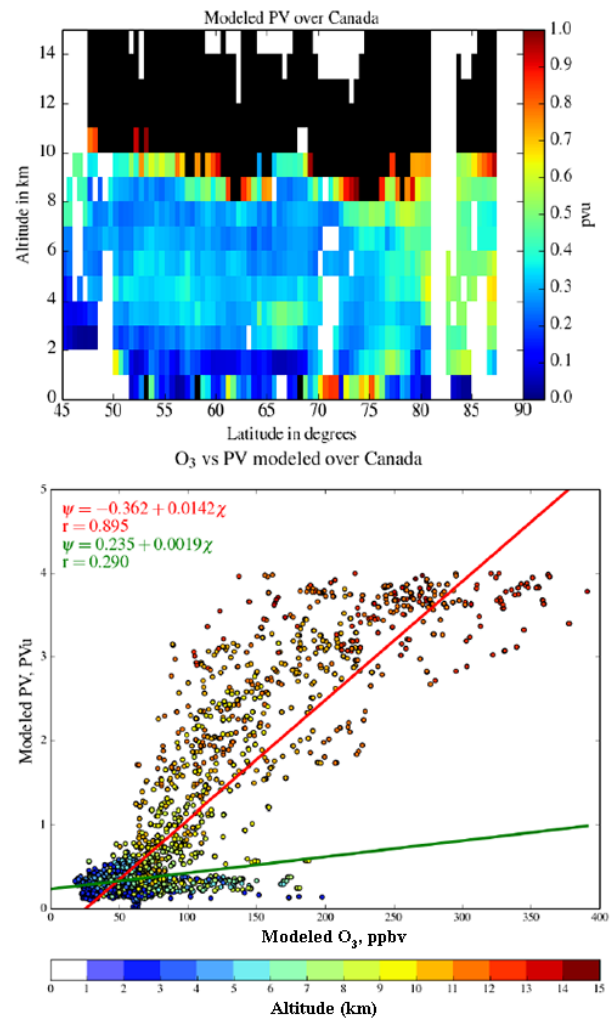
Figure 8. Latitudinal cross section of the average PV profiles over Canada for the summer measurement distribution using the WRF- Chem simulation (top panel). Scatterplot of modeled O 3 in ppbv vs. PV in PVu using an altitude color coded scale (bottom panel). Stratospheric data points with PV > 4PVu are not included. The regression line parameters and the Pearson correlation coefficient with its p value are also given for the PV range 0–4PVu (red) and 0–1PVu (green).